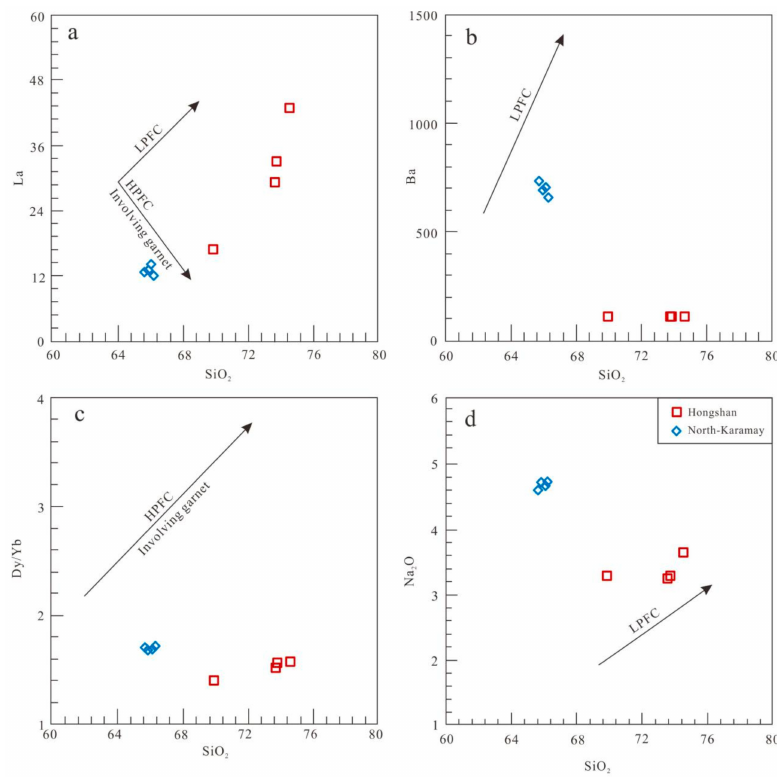
Figure 10. Plots of ( a ) SiO 2 vs. La, ( b ) SiO 2 vs. Ba, ( c ) SiO 2 vs. Dy / Yb, and ( d ) SiO 2 vs. Na 2 O diagram. Fractional crystallization trends in (a–d): HPFC, high-pressure fractional crystallization involving garnet [100]; LPFC, low-pressure fractional crystallization involving olivine + clinopyroxene + plagioclase + hornblende + titanomagnetite [88].